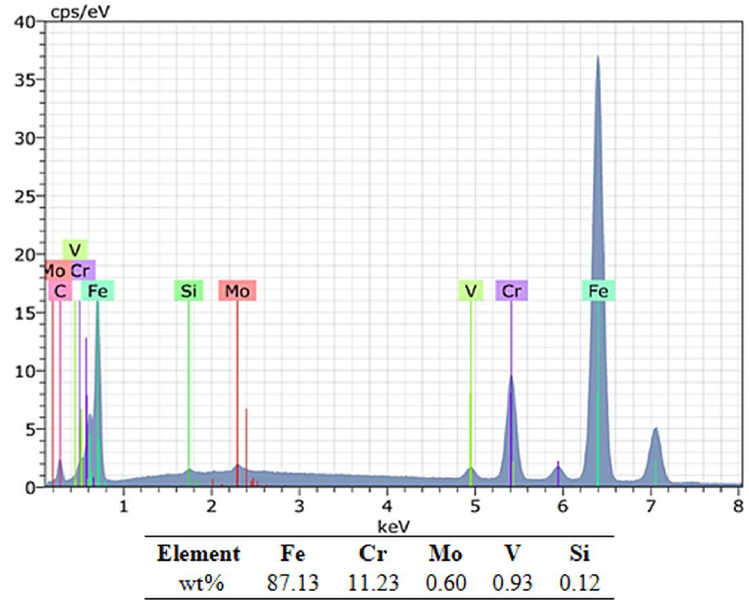
Figure 6. Spectrogram of X22CrMoV12-1 alloy in point 1.